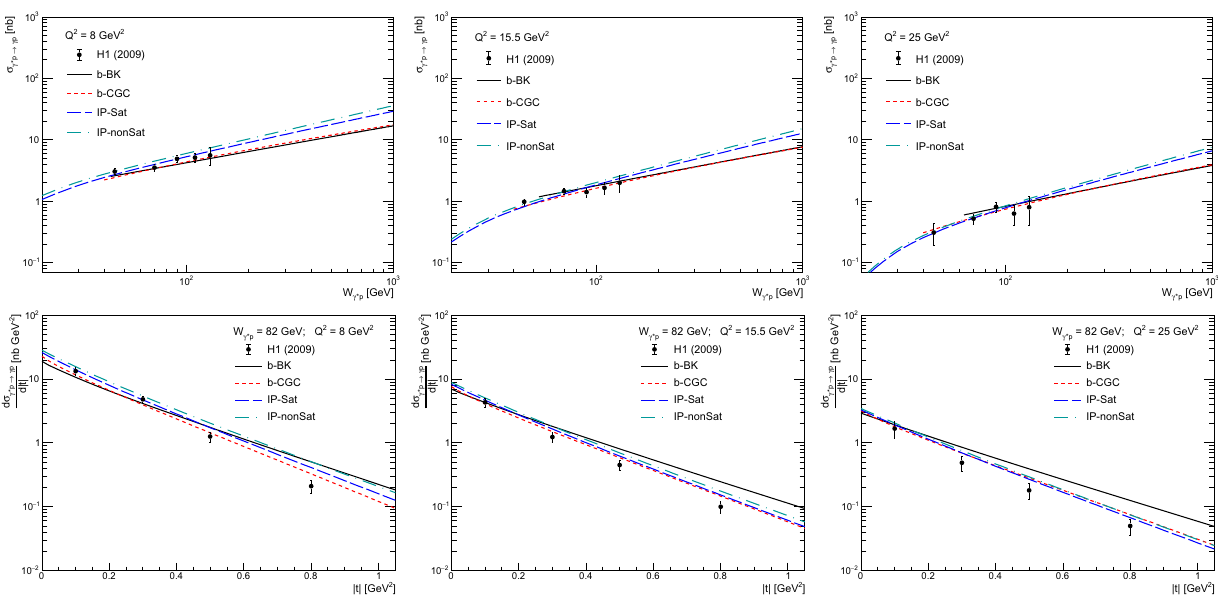
Fig. 4 Predictions for the energy dependence (upper panels) and t -distributions (lower panels) of the DVCS process in ep collisions at HERA derived considering distinct models for the dipole-proton scattering amplitude and different values of the photon virtuality. Data from H1